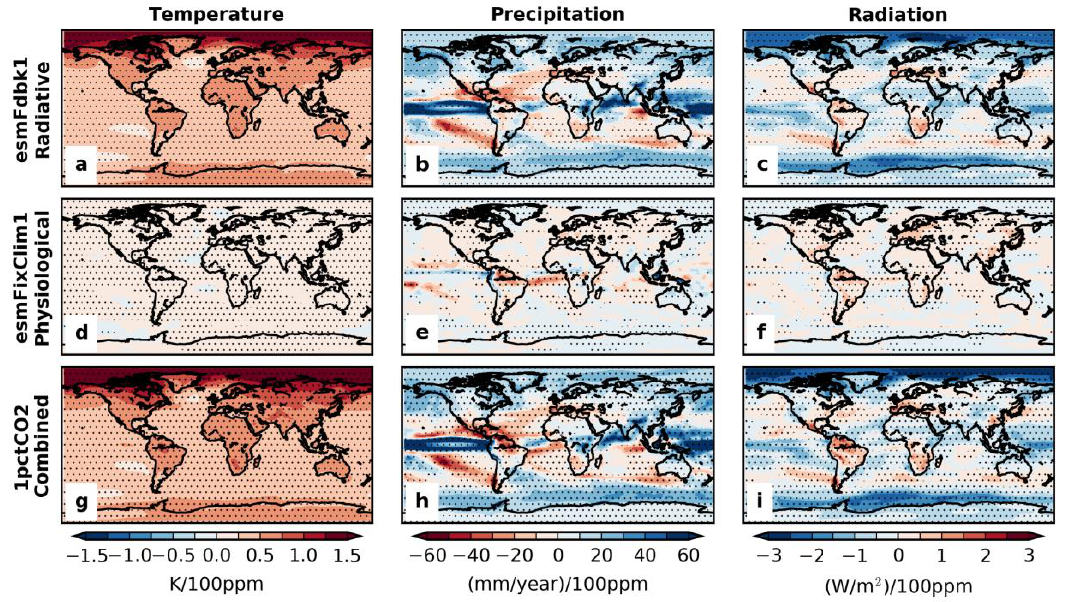
Figure 8. Spatial distribution of the additive and counteracting impacts of CO 2 on climate limiting factors. Temperature, ( a , d , g ); precipitation, b , e , h ; and solar radiation, ( c , f , i ). In order to assess the contribution of radiative and vegetation physiological effects on climate and vegetation, we used an eight-model [highlighted in Table 1] ensemble to compare three CMIP5 experiments, each of which was run for 140 years and experiences a constant CO 2 at pre-industrial levels and/or CO 2 increasing by 1%/year to 4xCO 2 : (1) In the radiative experiment ( a – c ), CO 2 increases for the atmosphere but stays constant for vegetation and the carbon cycle and hence the direct effects of CO 2 on plants are suppressed; (2) in the vegetation physiology experiment ( d – f ), CO 2 increases by 1%/year to 4xCO 2 for vegetation and the carbon cycle — thereby reducing stomatal conductance and providing CO 2 fertilization — but stays constant at 280 ppm for the atmosphere and thus the radiative effect is suppressed; (3) in the combined experiment ( g – i ), CO 2 concentration increases for the full Earth system. The changes are the mean of the last ten years minus the mean of the first ten years. Stippling indicates that the trend in the 140-year ensemble mean is significant at the 95% level from a Mann–Kendall trend test.